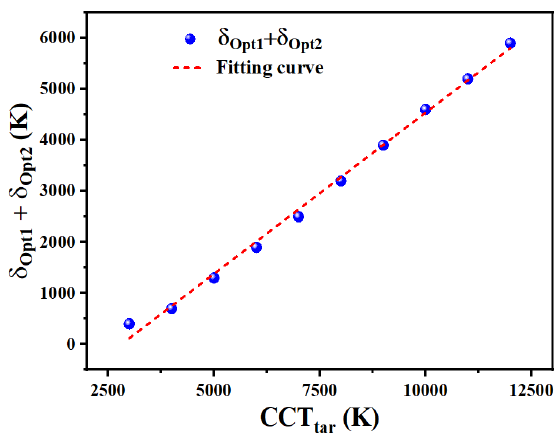
Figure 6. Data and fitting curve of ∑ ( δ Opt1 , δ Opt2 ) under different CCT tar